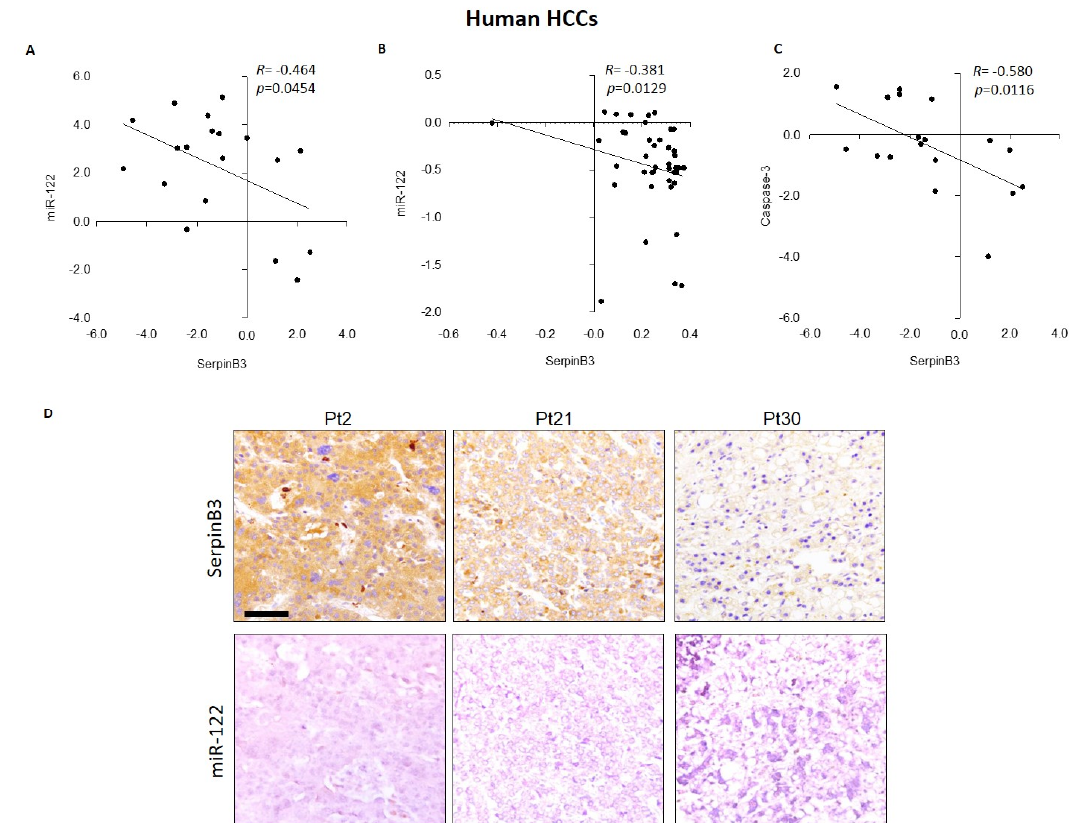
Figure 3. (A) Correlation graphs in human HCC tissues between miR-122 and SerpinB3 mRNA and (B) protein levels, as detected by qPCR and tissue microarray, respectively. Regarding the qPCR analysis, we considered only HCC samples with a Ct value lower than 35, which resulted in 19 out of 35 tested HCC samples. β-Actin was used as housekeeping gene for SerpinB3 normalization; U6RNA was used as housekeeping gene for miR-122 analysis. (C) Correlation graphs in human HCC tissues between SerpinB3 and caspase-3 mRNA levels, as detected by qPCR analysis. (D) Representative images of tissue microarray (TMA) in HCC samples from three patients (Pt2, Pt21 and Pt30) with different expression of miR-122 and SerpinB3 in sequential tissue slides. Scale bar 100 μM.